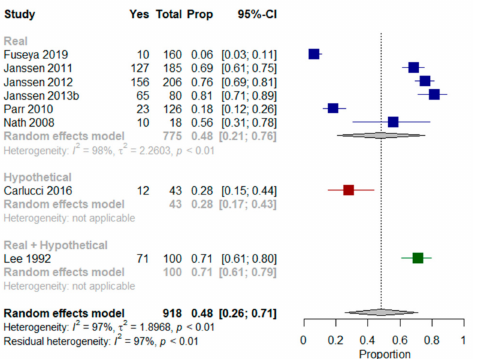
Figure 4. Forest plots comparing willingness to receive mechanical ventilation: Shows results (%) from studies where the context was a real scenario, a hypothetical scenario or both